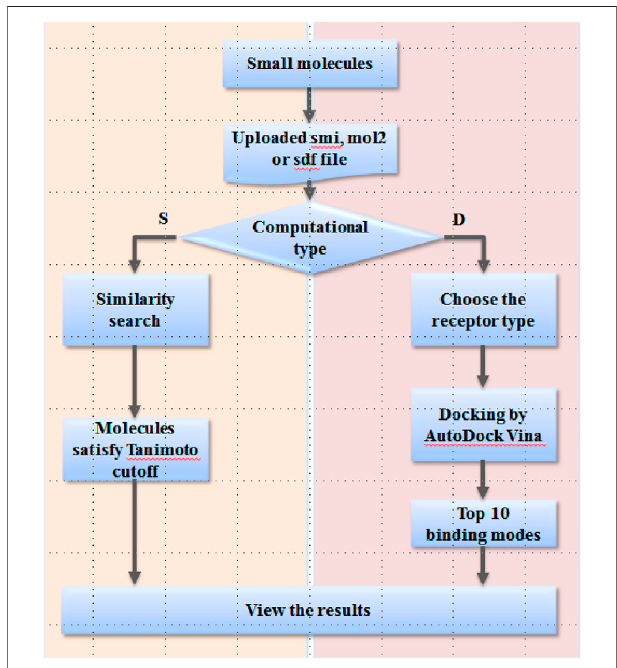
FIGURE 2 | Work fl ow of the EARDB.